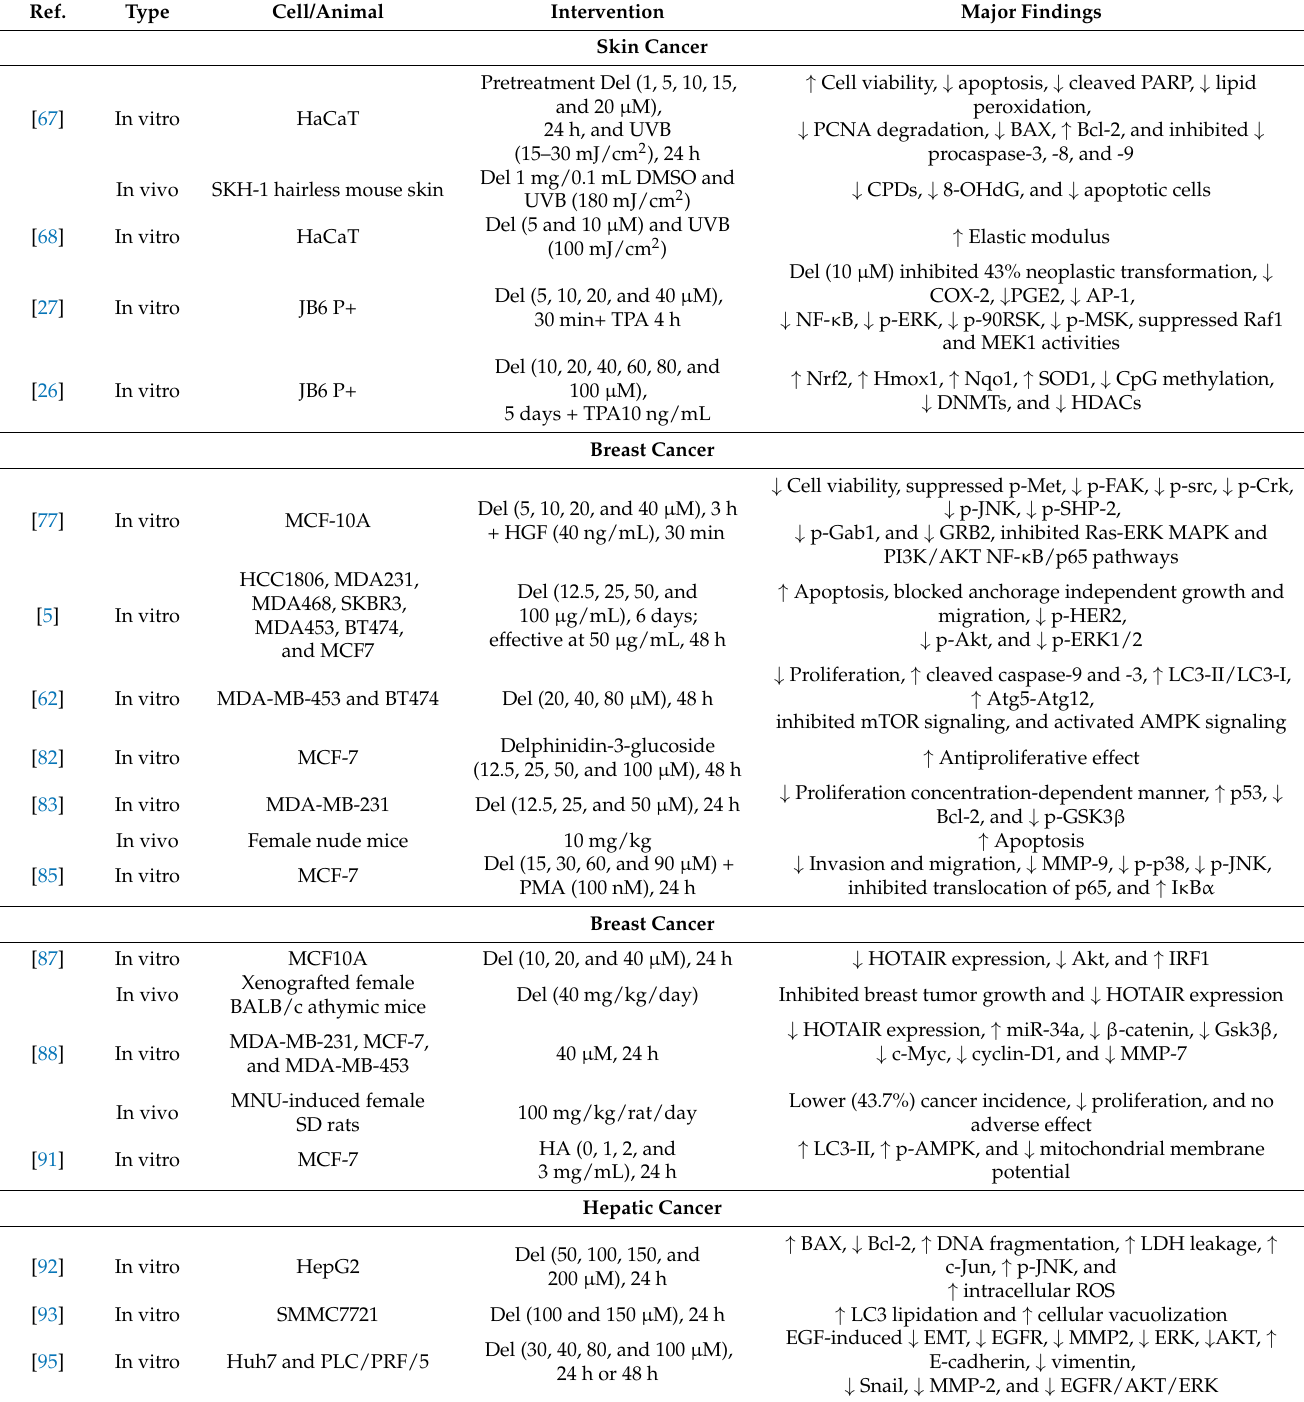
that inhibits cell migration in human U-87 MG glioblastoma, as evidenced by reduced TGF/Smad2 and TGF/ERK signaling pathways, as well as decreased expression of EMT markers, fibronectin and Snail, among all anthocyanidins studied (Table 2) [114]. Table 2. Preventive and anticancer effects of delphinidin and its glycosides in models of skin cancer, breast cancer, hepatic cancer, leukemia, bladder and mesenchymal tumors, glioma, and osteosarcoma.